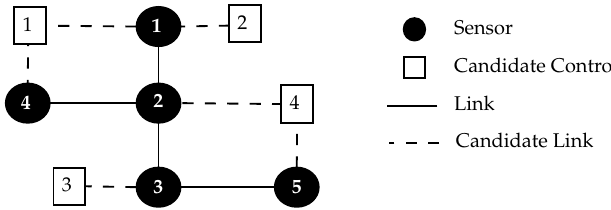
Figure 1. A network with four sensors and three candidate controllers. Table 1. Example